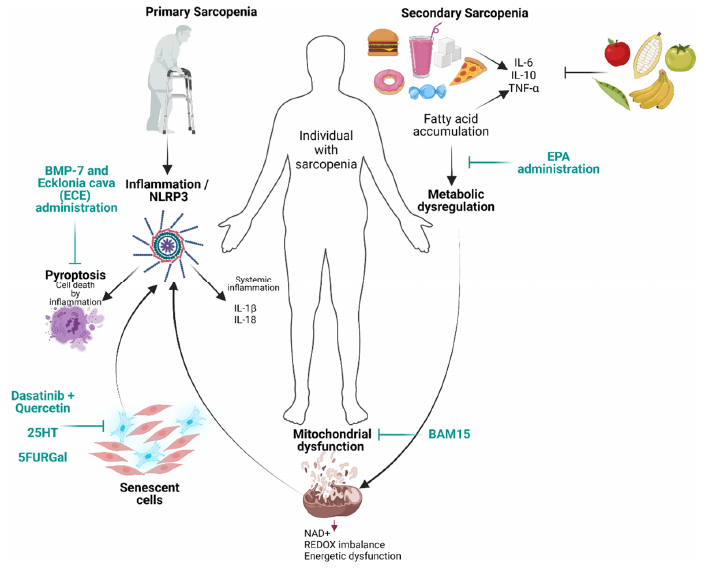
Figure 1. Illustration of factors involved in primary and secondary sarcopenia. New potential agents to treat sarcopenia as well as novel therapeutical approaches which are shown in green color. Created with BioRender.com, accessed on 30 May 2022.